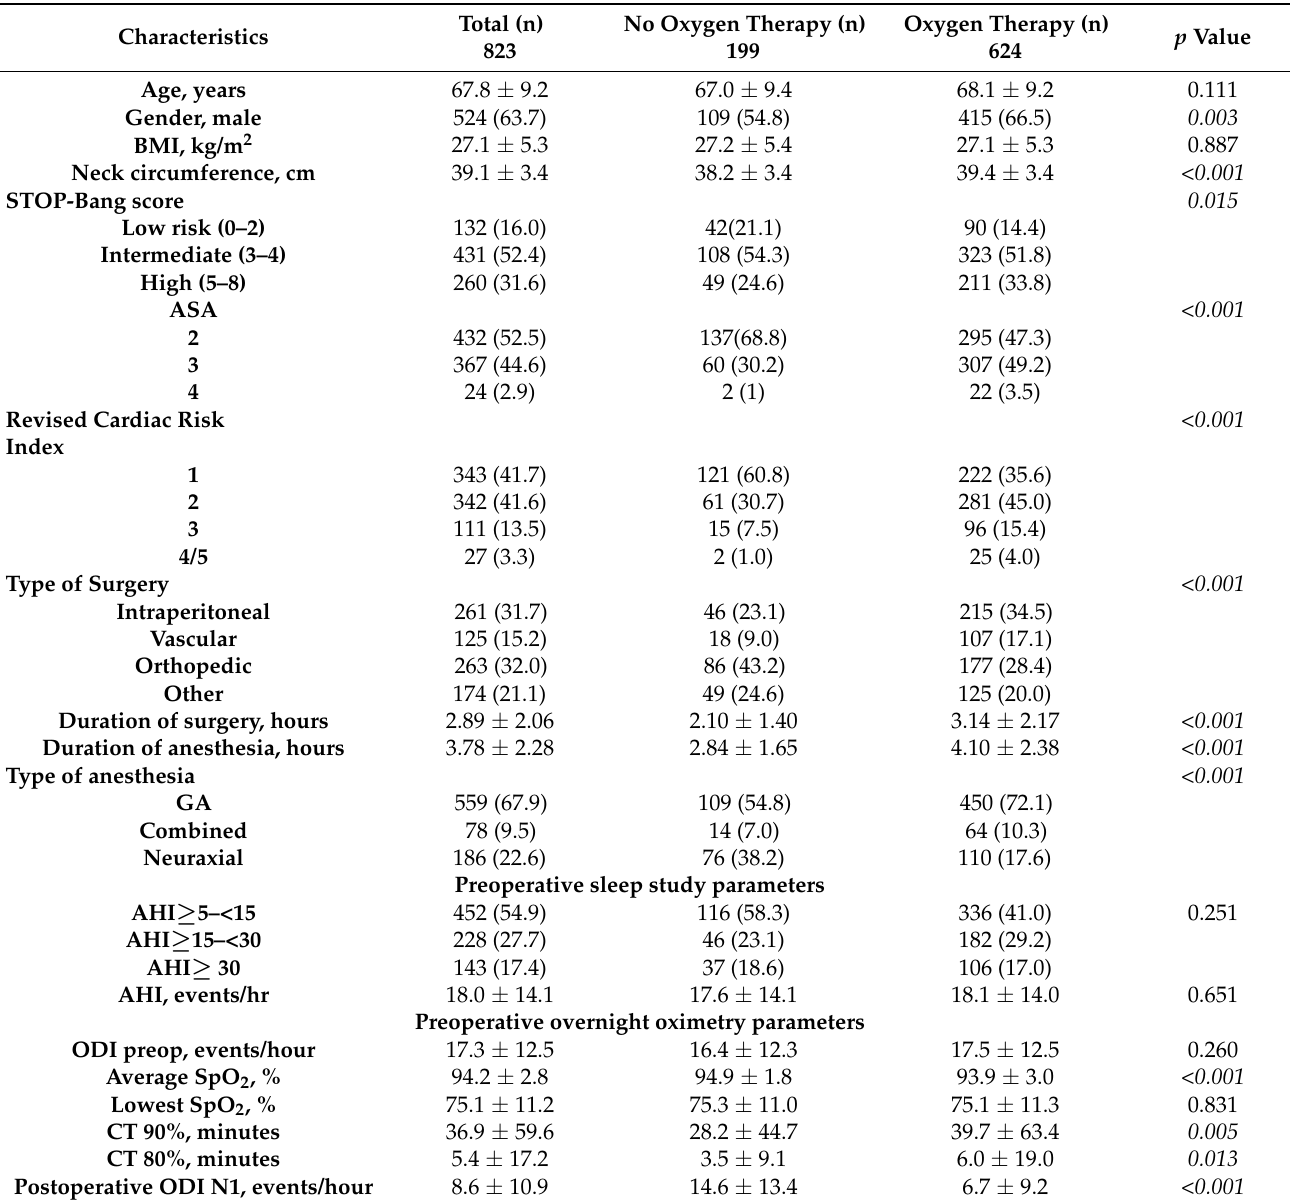
Table 1. Characteristics of OSA patients requiring oxygen therapy versus no oxygen therapy on postoperative night